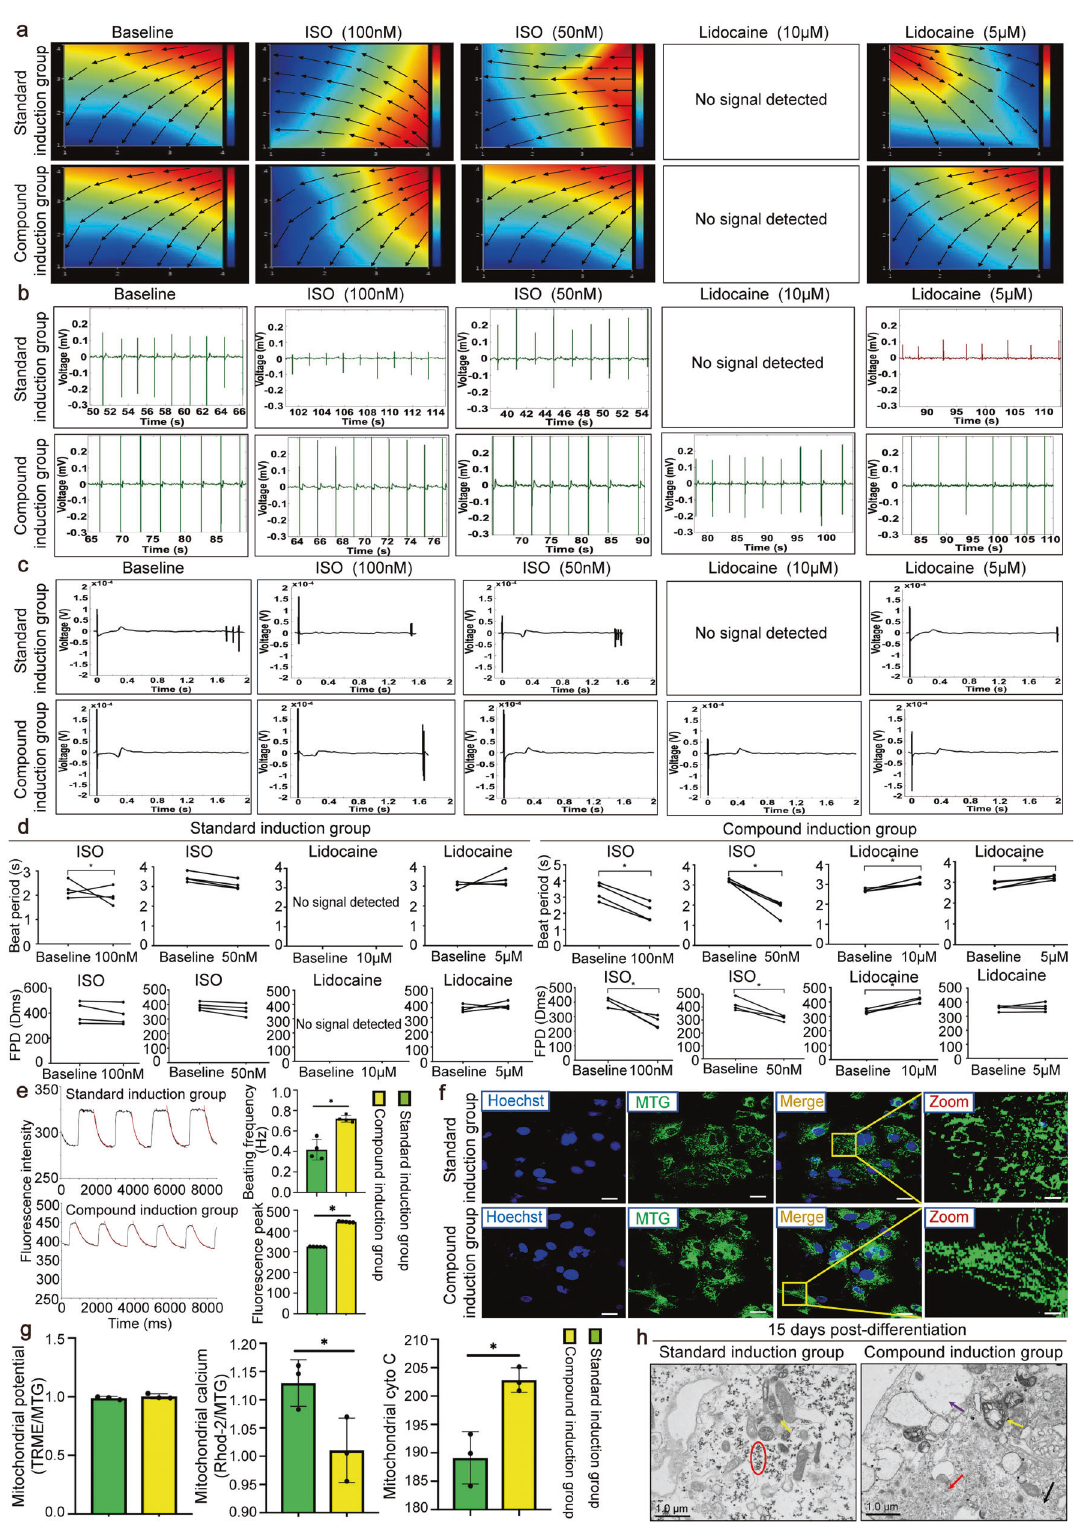
the above-mentioned regulation of apoptosis. The activation of PKB promoted myocardial cell repair was basically achieved by activating the PI3K/Akt pathway, which demonstrated that the compound induced hiPS-CMs transplantation effects were associated with anti-apoptosis responses such as activation of PI3K/Akt pathway.